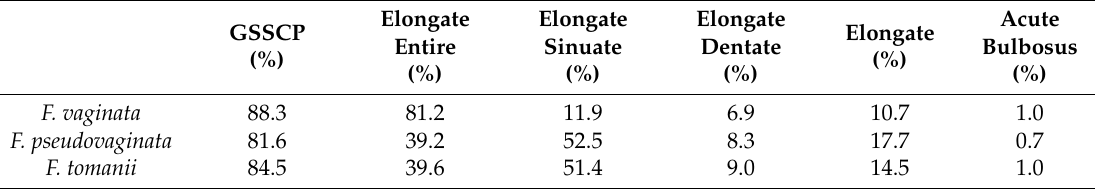
Figure 7. Light microscopic pictures of phytoliths. ( A ) ELONGATE DENTATE ( B ) ELONGATE ENTIRE ( A , B ) Silicified epidermal long cells) ( C ) RONDEL (silicified epidermal short cell), ( D ) epidermal tissue fragments with short cells and ELONGATE SINUATE phytoliths in them. (v) F. vaginata (p) F. pseudovaginata (h) F. tomanii . The line represents 20 µm. Table 1. Frequency (%) of phytolith morphotypes in the leaves of Festuca species (sum of all the phytoliths is 100%). Frequency of the ELONGATE morphotypes means the percentage of the amount of ELONGATE cells (sum of the ELONGATE cells is 100%). GSSCP = grass silica short-cell